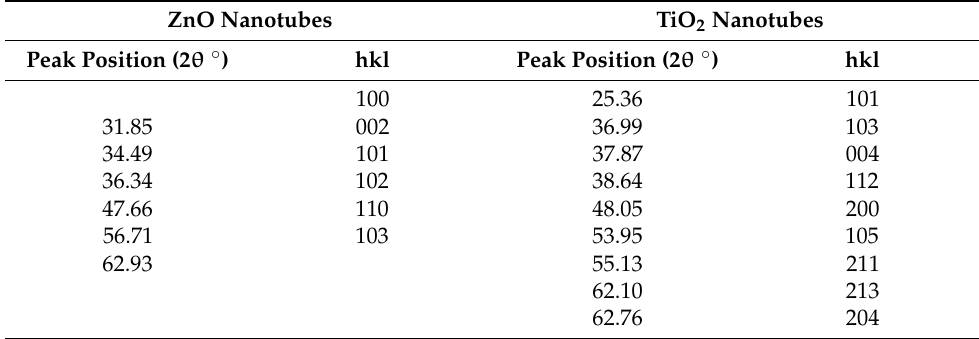
Table 1. XRD data for ZnO and TiO 2